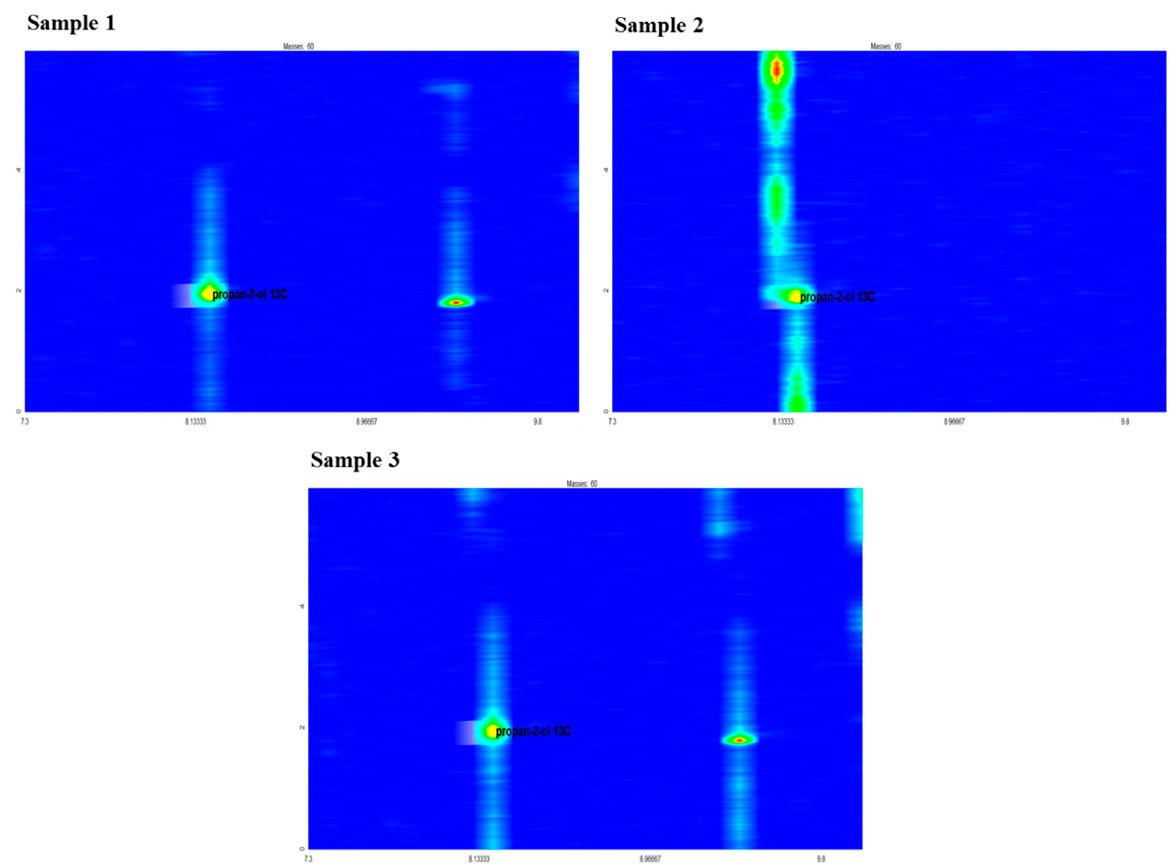
Figure 2. 1 H NMR spectra in the chemical shift region associated with acetone and acetic acid signals. (Sample no. 1—distillate obtained from mash inoculated with yeast; Sample no. 2—distillate obtained from mash inoculated with LAB; Sample no. 3—distillate obtained from mash inoculated with yeast and LAB).